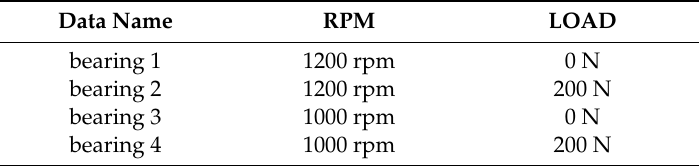
Table 2. Operating conditions.